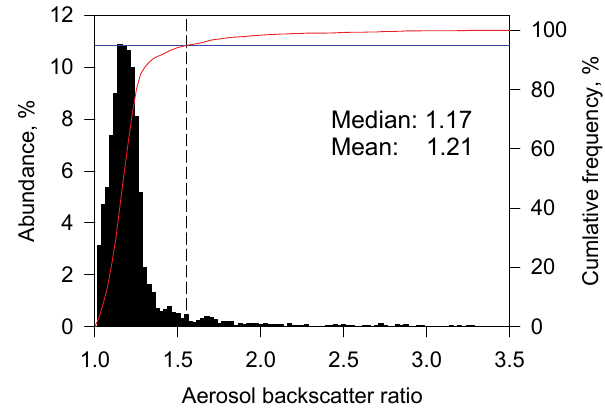
Fig. 9. Histogram of the filtered aerosol backscatter ratio at 500m over Syowa Station, Antarctica. The red line, horizontal blue line, and vertical dashed line respectively indicate cumulative frequency, 95th percentile and value of 1.55 in the aerosol backscatter